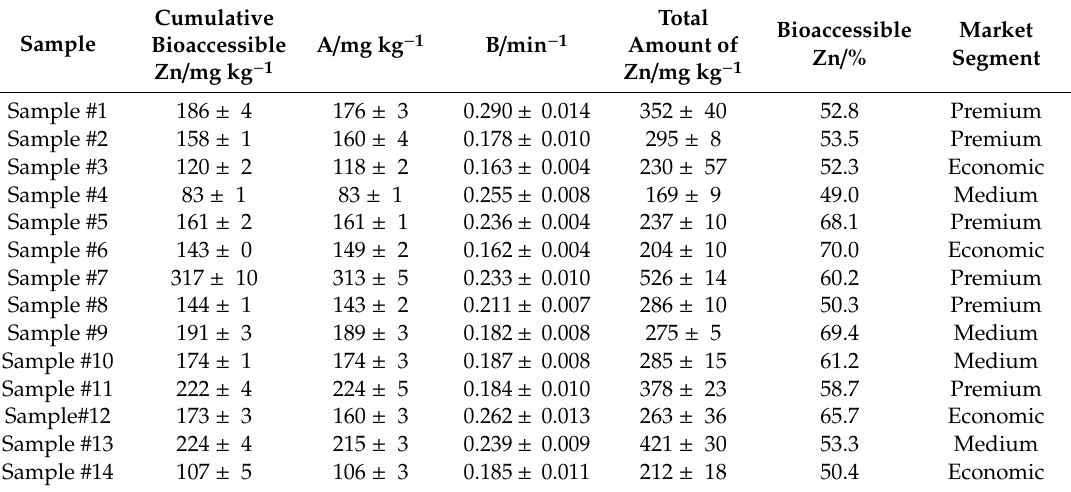
Table 2. Cumulative Zn obtained experimentally, parameters A (fast leachable amount) and B (associated rate constant) 1 , obtained after fitting of experimental data to the kinetic equation C(t) = A × (1 − e − Bt ), total amount of Zn obtained by inductively coupled plasma mass spectrometry, % of bioaccessible Zn, and market segment of the tested